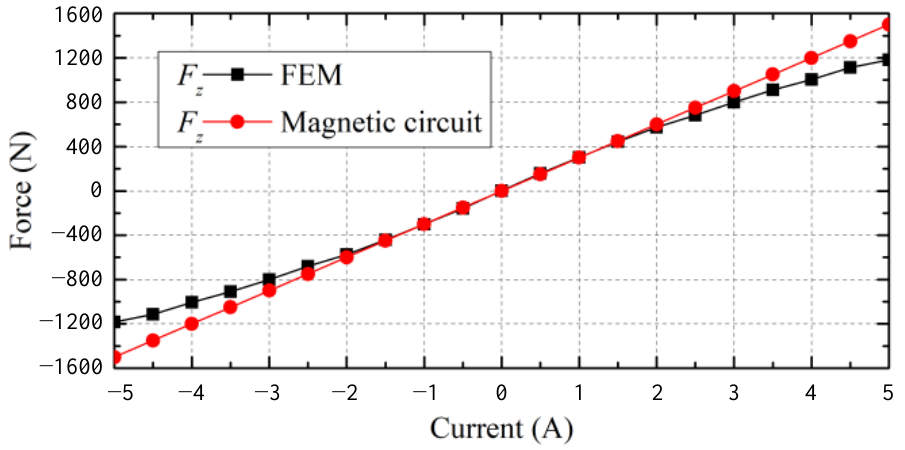
Figure 7. The curves show the correlation between axial suspension forces and axial current. In the third experiment, under the condition of a simultaneous application of radial and axial current, Figure 8 shows the variation between the force in the radial and axial directions and the current at the central position. There are six curves in Figure 8, three of which represent F x , F y, and F z calculated using FEM, and the other three represent F x , F y , and F z calculated using the equivalent magnetic circuit. The results of the analysis showed that the suspension forces of the combined action of axial and radial control currents were basically the same as those of the separate action of the two control currents, which means that the radial control fluxes and axial control fluxes were basically uncoupled. The difference between the two methods mainly results from the consideration of flux leakage, eddy current loss, and magnetic saturation. The flux leakage, eddy current loss, and magnetic saturation were considered in the FEM analysis but neglected in the equivalent magnetic circuit model. Nevertheless, the correctness of theoretical analysis was proved by a comparison of its results with those found using the FEM